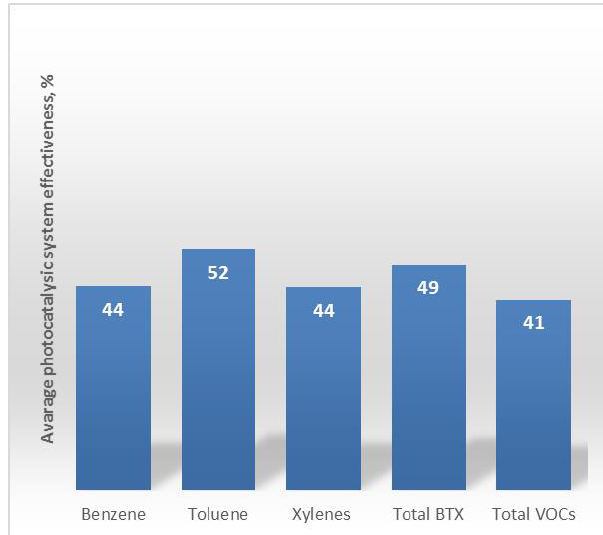
Fig. 4. Average photocatalytic system effectiveness, temperature 296 K